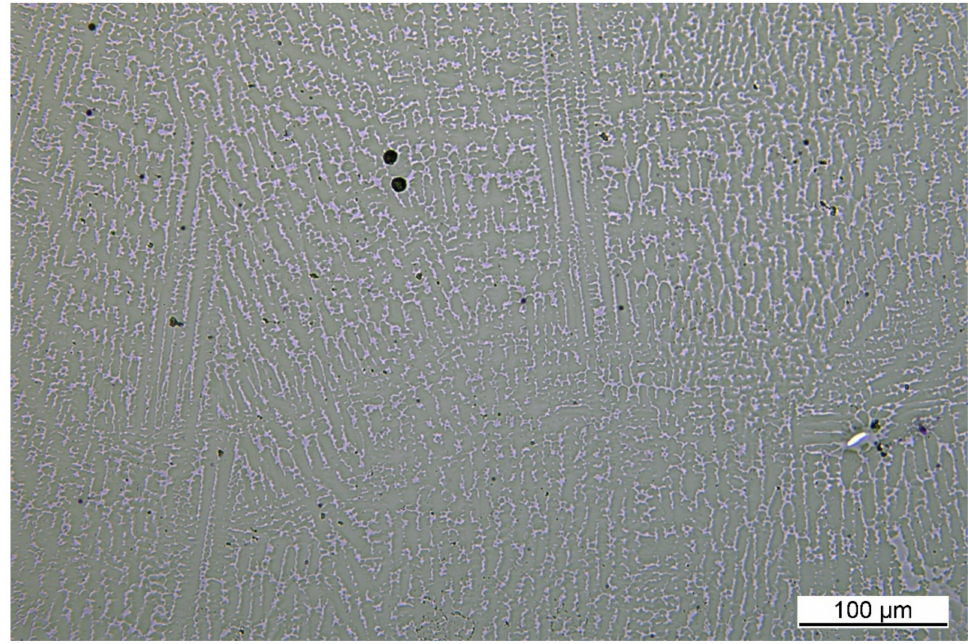
Figure 7. Microstructure of the complex concentrated and additive manufactured alloy (magnification 200 × ).